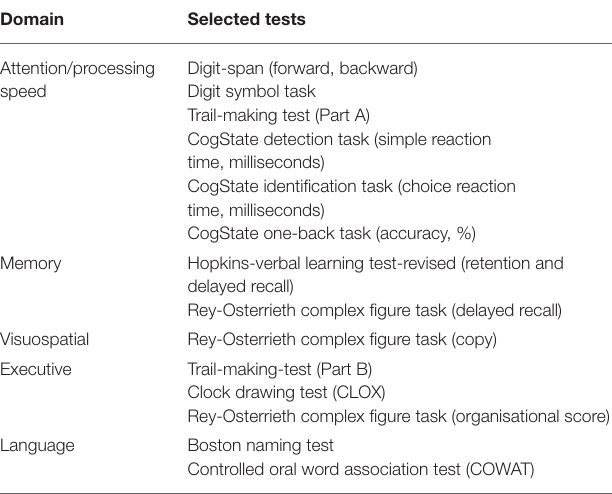
TABLE 1 | Summary of cognitive tests included under each cognitive domain.